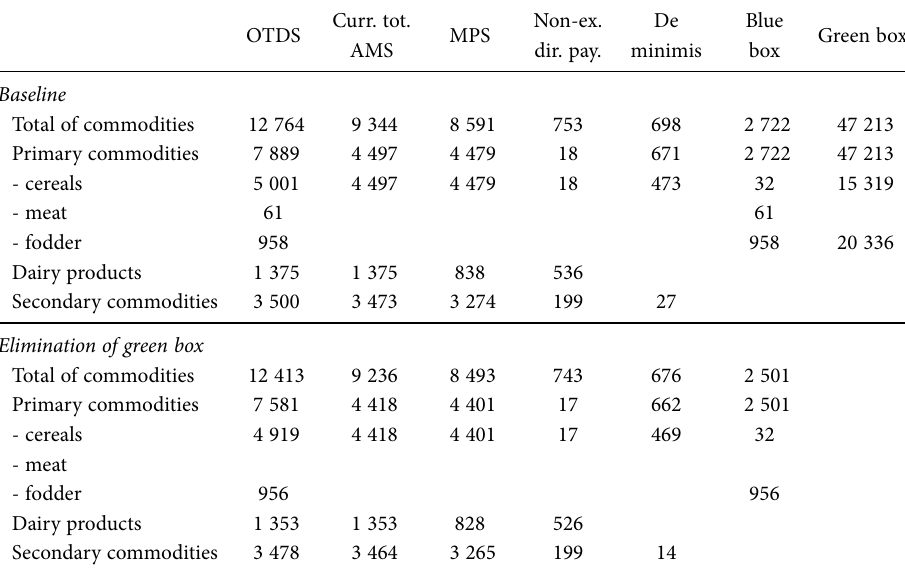
Table 5. WTO policy indicators a for the EU in 2020 by type of scenario (in mio